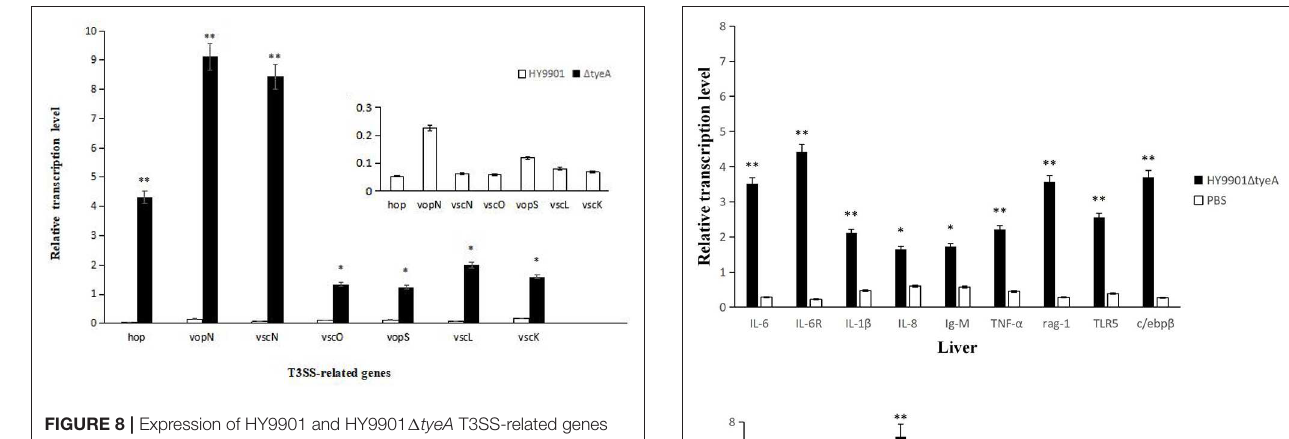
FIGURE 8 | Expression of HY9901 and HY9901 1 tyeA T3SS-related genes induced by DMEM. 1 tyeA had significantly increased expression of vscL , vscK , vscO , vopS ( p < 0.05), vopN , vscN , and hop ( p < 0.01). * indicates significant difference compared with the control group ( p < 0.05). ** indicates extremely significant difference compared with the control group ( p < 0.01).